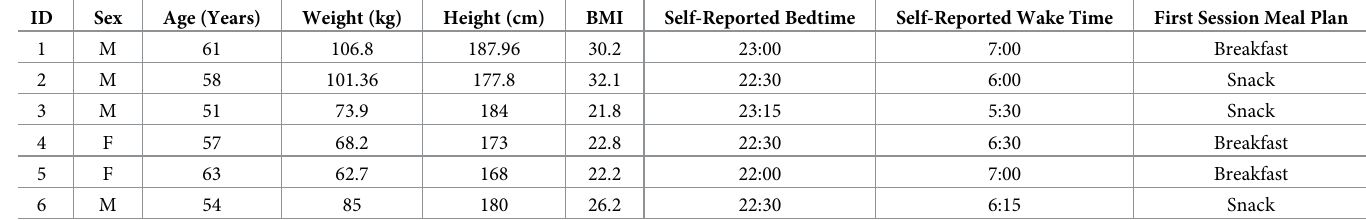
among all subjects when a lunch, dinner, and late-evening snack were presented. Red shaded areas indicate when late- evening snacks were given. Breakfasts and late-evening snacks contained the same number of calories and the same lipid, carbohydrate, and protein content (S1A and S1B Table). Error bars are the standard deviation ( n = 6). (D) Average difference in RER over the entire 56-h time course for the Breakfast Session subtracted from the Snack Session. Deviation from zero (horizontal black line) indicates where differences in RER occurred between subjects. Error bars indicate standard deviation in the differences. In Panels B, C, and D, times of meals are indicated by letters (B = breakfast, L = lunch, D = dinner, S = late-evening snack), and gray areas are lights-off (sleep) intervals. Mealtimes are shaded as in panels A–C; breakfasts and snacks occurred only in their respective sessions. All RER data were collected minute by minute, and in this figure, the minute-by-minute data were binned and averaged for all 60 values within an hour. Abscissa are clock time. RER, respiratory exchange ratio. https://doi.org/10.1371/journal.pbio.3000622.g001 (indicating primarily carbohydrate and protein catabolism). Therefore, humans share with other mammals a daily rhythm of substrate metabolism as assessed by indirect calorimetry [28,29]. However, in the Snack Session, the metabolism of the same subjects was not as strongly rhythmic and displayed a lower amplitude rhythm of RER that did not drop into a largely lipid-catabolic mode (Fig 1C). When the difference between the RER on the Breakfast versus the Snack Sessions is calculated as a function of daily time, the most significant differ- ence was noted during the inactive sleep phase, during which LO predominates in the Break- fast Session, while the RER remains high in the Snack Session (Fig 1D). We initially predicted that the session-dependent RER patterns were due to differences between the sessions in physical activity, sleep disruption, CBT, or the phasing/amplitude of the circadian clock. However, none of these parameters were different between the sessions. Actigraphy confirmed that the subjects’ overall activity levels did not differ significantly between the two sessions (S1A and S1B Fig, p = 0.538). Moreover, actigraphy can provide an assessment of restlessness during sleep [30] and by this criterion, the sleep quality was equiva- lent between the Breakfast versus Snack Sessions (S1A and S1B Fig). The daily rhythm of the CBT, which is frequently used as a marker of the central circadian clock in humans [9,31], did not show significant differences in the phasing or amplitude of their CBT rhythms between the two sessions (S1C and S1D Fig, p = 0.218). Moreover, the circadian rhythm of overall MR [8] was not different in phase or amplitude between the two sessions (Fig 2B, p = 0.11). There- fore, neither differences in CBT (S1 Fig) nor the thermic effect of food (TEF; see below) were responsible for the session-dependent RER differences. The phasing or amplitude of the daily rhythms of master clock markers (plasma melatonin and cortisol) is also not responsible, as reported by Wehrens and colleagues, who found no differences in those rhythms in a meal timing study using a similar protocol to ours [32]. Finally, our subjects kept a regularly timed sleep/wake cycle prior to the metabolic chamber experiments so that their internal rhythm was in phase with the light/dark cycle during the 56-h experiment (S2 Fig and Table 1). These results suggest that the change in meal timing altered the RER rhythm (i.e., its amplitude) without changing overall activity, sleep quality, body temperature, or the phase relationship between circadian rhythms and the daily light/dark schedule. Table 1. Subjects involved in this